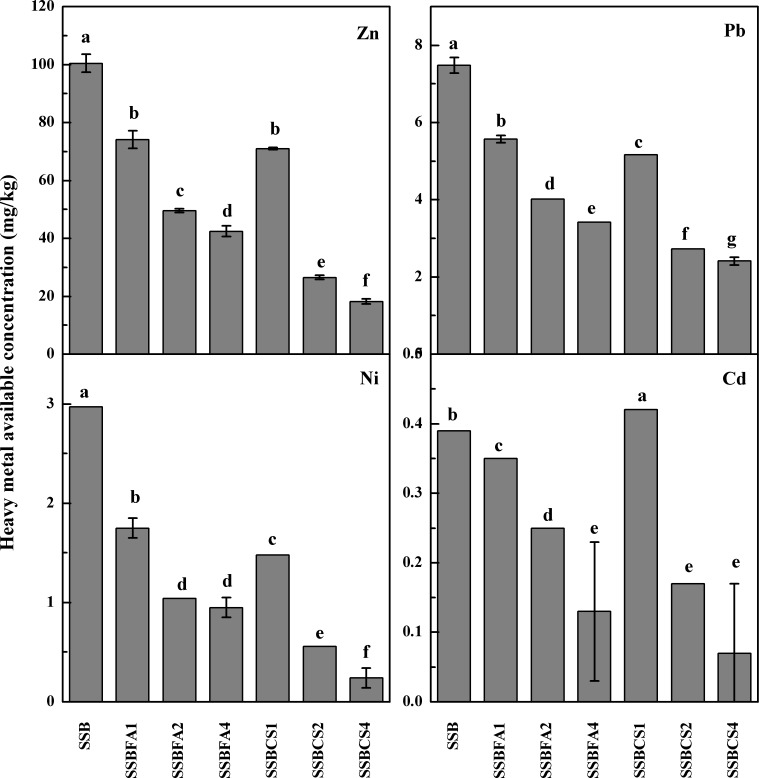
Available heavy metal concentrations (DTPA-CaCl2-TEA-available) in raw SSB (0% stabilizer) and SSB with FA or CS incorporated at 1%, 2% or 4%.